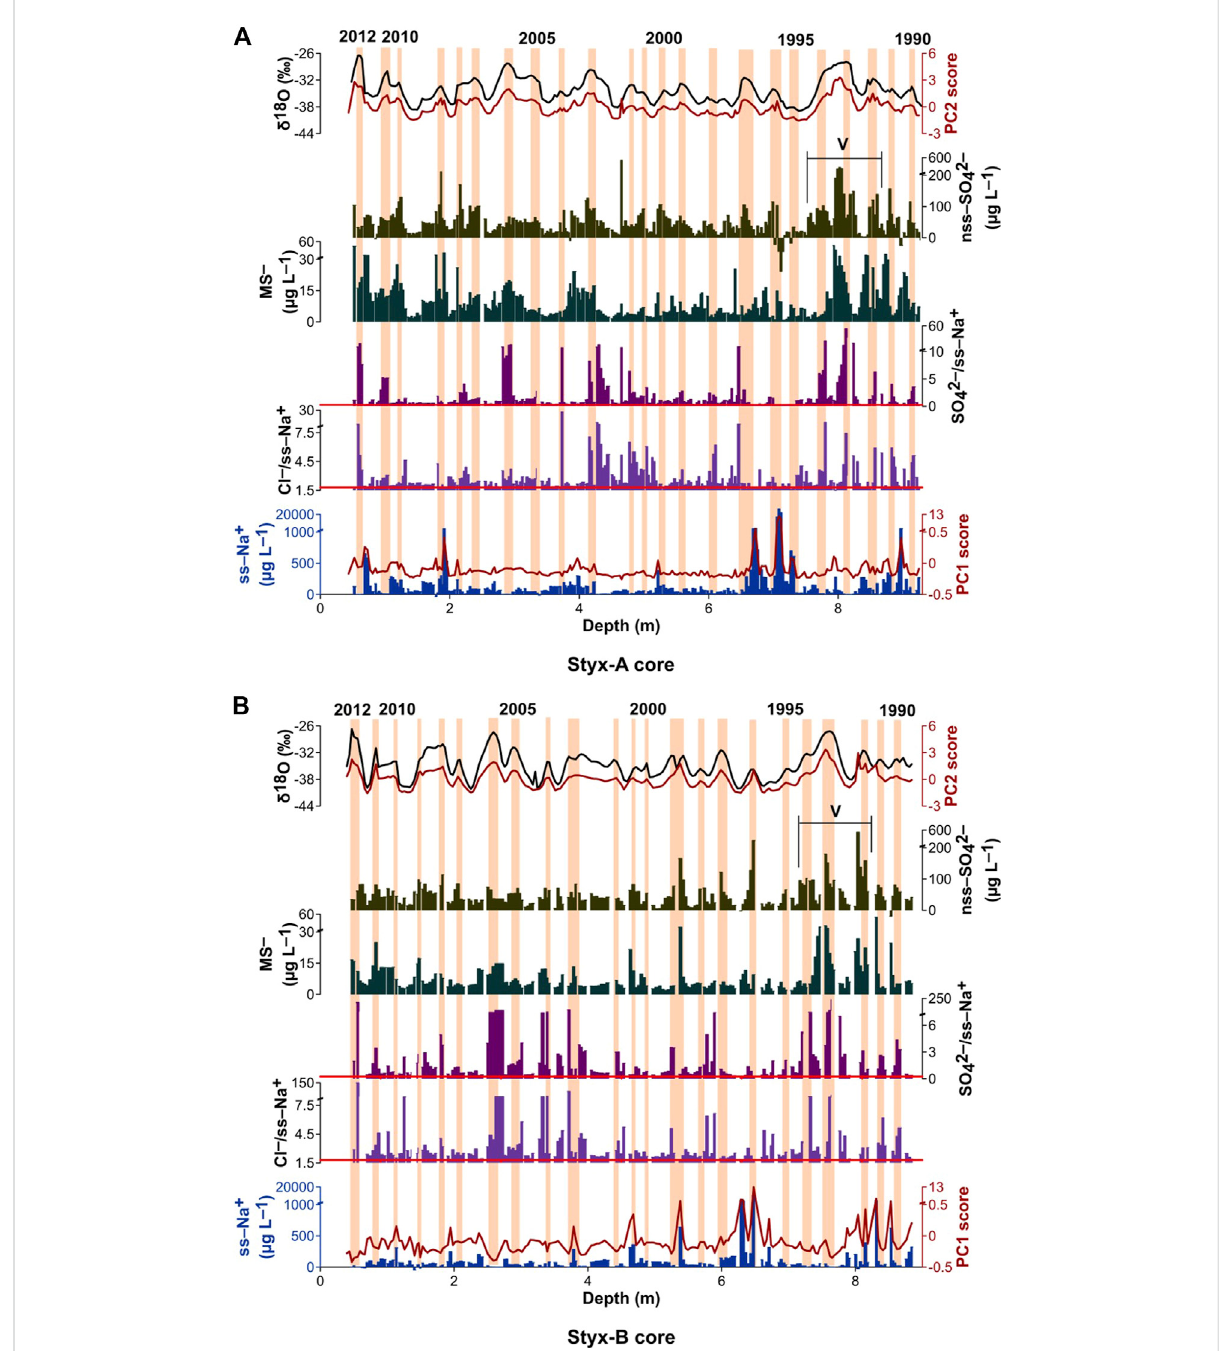
Annually resolved records of δ 18 O, PC2 score, nss – SO 4 2 − , MS – , SO 4 2 − /ss – Na + , Cl − /ss – Na + , ss – Na + , and PC1 score from (A) the Styx-A core and (B) the Styx-B core. Pro fi les of δ D, Cl − , ss – SO – , and ss – Ca 2+ are not shown because strong correlations between δ 18 O and δ D and among ss – Na + , 4 2 ss – Ca 2+ , Cl − , and ss – SO 4 2 – are observed ( r > 0.99). Horizontal red lines represent the SO 4 2 – /ss – Na + and Cl − /ss – Na + ratios in seawater (0.25 and 1.80 w/w, respectively). Vertical orange areas refer to depth intervals assigned to summer seasons of each year. ‘ V ’ denotes volcanic intervals with the well-identi fi ed large volcanic deposition from Mt. Cerro Hudson and Mt. Pinatubo (Nyamgerel et al.,